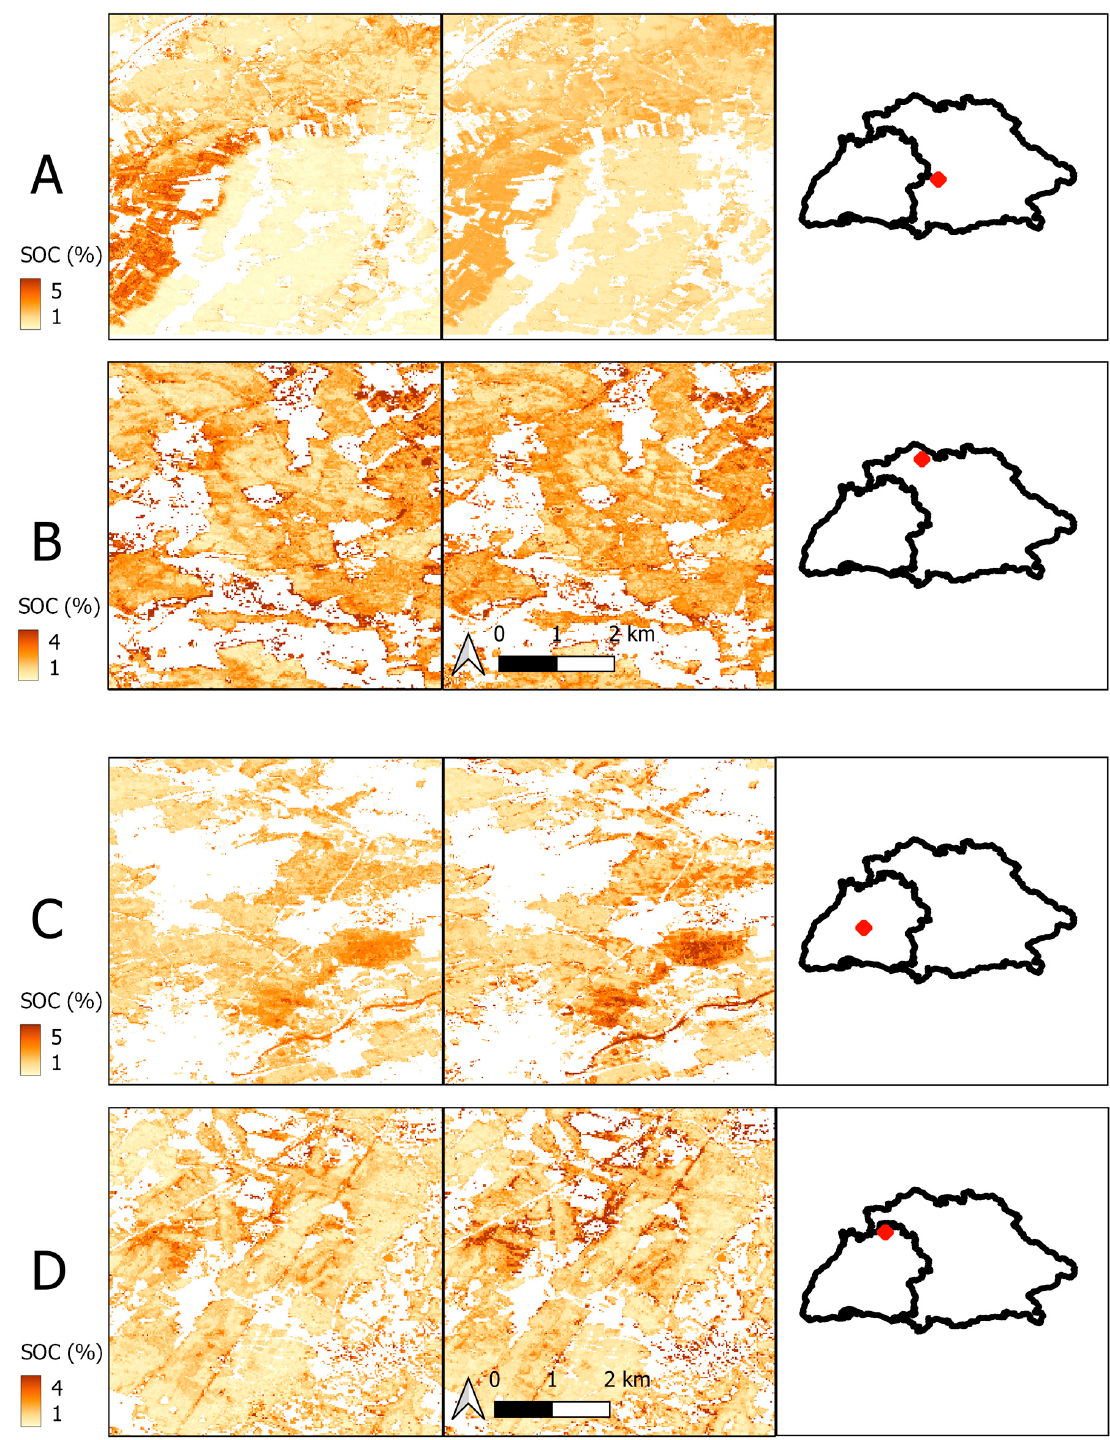
Figure 10. Influence of the model transfer on the SOC prediction for satellite models in BY ( A , B ) and BW ( C , D ). Maps of non-transferred models ( left ) and transferred models ( right ). Sites with dissimilar soil conditions in both states ( A , C ) are compared to sites with similar soil conditions ( B , D ). Red dots show the locations within the research area.